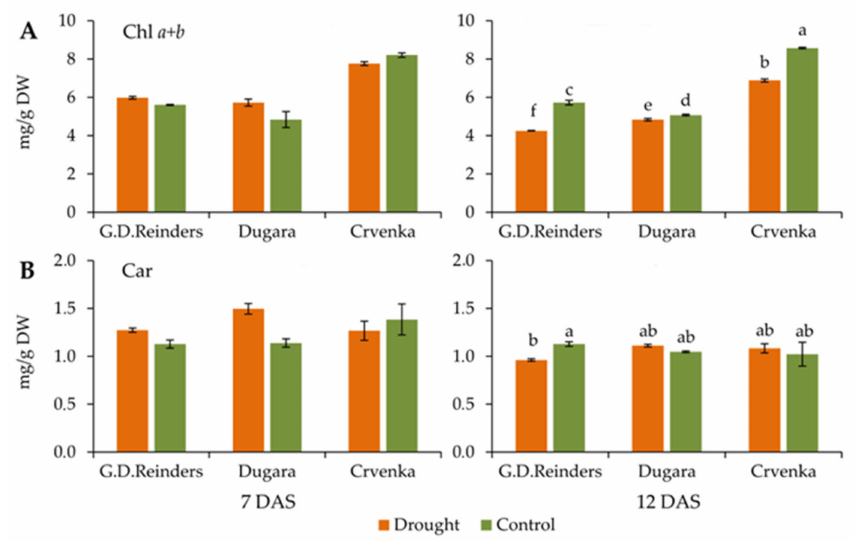
Figure 4. Total chlorophyll (Chl a + b ) ( A ) and carotenoid (Car) ( B ) contents measured in control and drought-stressed apple cultivars (“Golden Delicious Reinders”, “Crvenka” and “Dugara”) at 7 and 12 DAS (day after stress). Values are mean ± SE ( n = 5). Different letters indicate significant difference among treatments and cultivars at p < 0.05 according to LSD